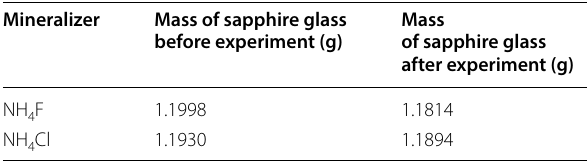
Table 3 Mass of sapphire glass before and after the corrosion resistance test (conditions: 450 °C, 102